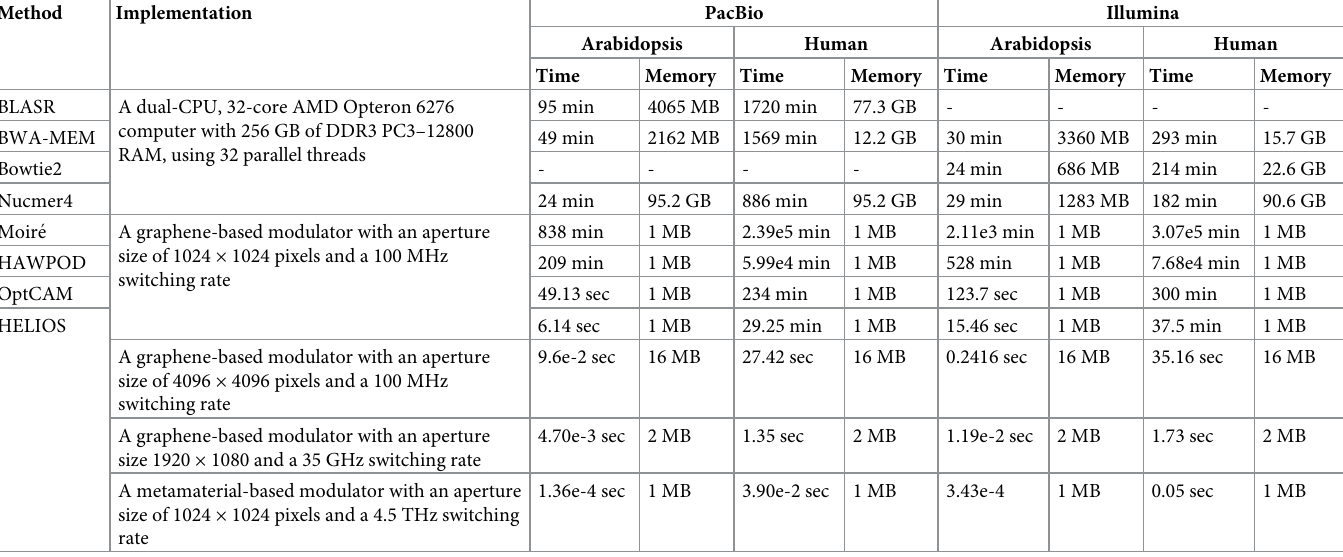
Table 19. Processing time and memory usage to align PacBio and Illumina reads to the Arabidopsis and Human reference genomes by HELIOS optical architecture, compared to BLASR, BWA-MEM, Bowtie2, Nucmer4, Moire´ Technique, HAWPOD, and OptCAM. In this regard, the analytical estimation of the processing times of the HELIOS optical architecture, OptCAM, HAWPOD, and Moire´ Technique, are reported by employing a typical graphene-based modulator with an aperture size of 1024 × 1024 pixels and a 100 MHz switching rate. In versus, the processing times of Nucmer4, Bowtie2, BWA-MEM, and BLASR are measured on a dual-CPU, 32-core AMD Opteron 6276 computer with 256 GB of DDR3 PC3–12800 RAM, using 32 parallel threads, as reported in [14]. The report includes the times to build the genome index and to align the sequences. Moreover, the processing times of HELIOS optical architecture are also reported for more recently developed modulators with various aperture sizes, such as 1920 × 1080 and 4096 × 4096 pixels, as well as various switching rates, including 35 GHz [72] and 4.5 THz